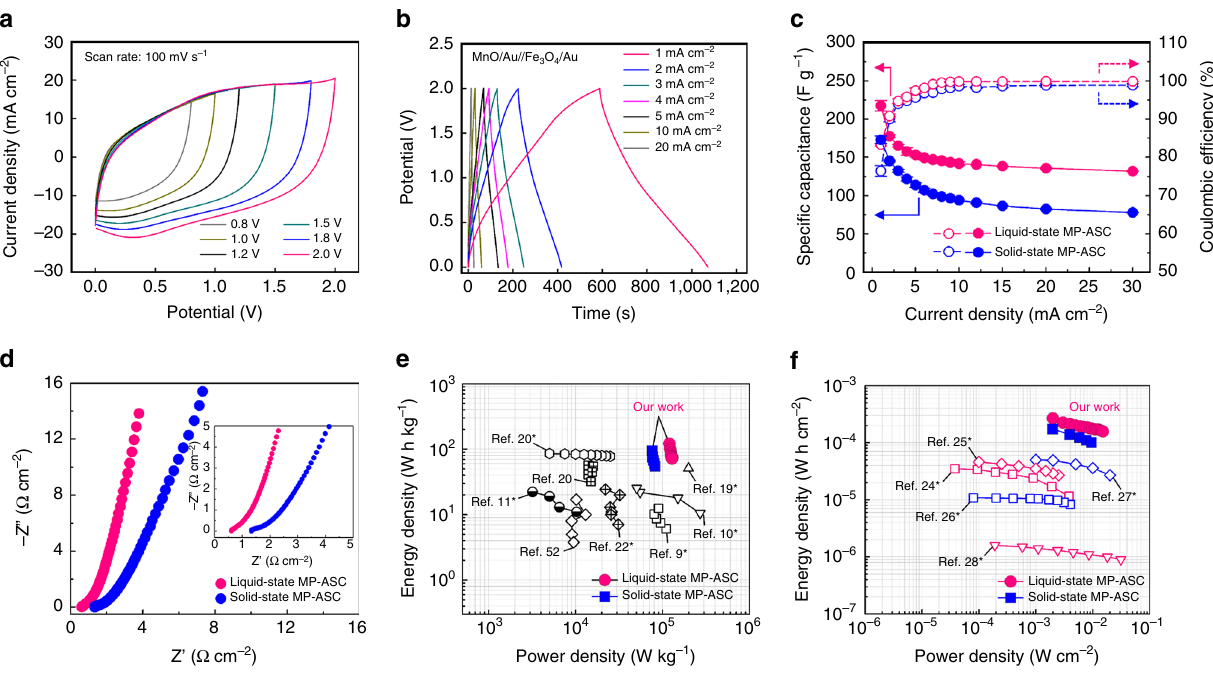
Fig. 5 Electrochemical properties of the MP-asymmetric supercapacitor (ASC). a CVs of the liquid-state MP - ASC (i.e., MnO/Au//Fe 3 O 4 /Au in 1 M Na 2 SO 4 ) at a scan rate of 100 mV s − 1 . b Galvanostatic charge/discharge (GCD) curves of the liquid-state MP-ASC at various current densities in the range of 1 – 10 mA cm − 2 . c Speci fi c capacitance and coulombic ef fi ciency of the MP-ASC as a function of the current density. d Nyquist plots of the MP-ASCs. The inset shows a higher magni fi cation of the high-frequency region. Ragone plots of the solid- and liquid-state MP-ASCs as a function of e the total mass of the active energy materials and f the area of the MP-ASCs compared with previously reported fl exible asymmetric supercapacitors